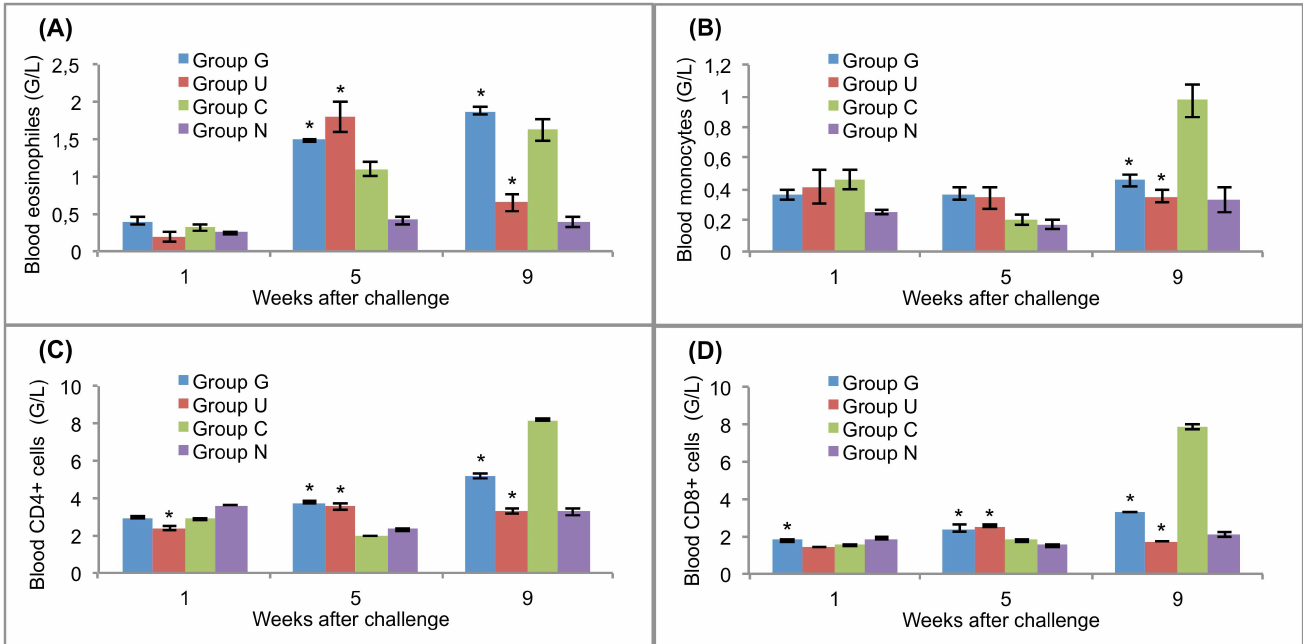
Fig 4. Leukocyte responses in the blood of vaccinatedand control rats to challenge infections. (A) eosinophils. (B) monocytes. (C) CD4+ T lymphocytes. (D) CD8+ T lymphocytes. Group G–Lyophilised lettuce expressingthe mature CPFhW enzyme flankedby Gly-rich linkers; Group U– Lyophilised lettuce expressingthe mature CPFhW protein fused with ubiquitin;Group C–Lyophilised control lettuce; Group N–None. At each timepoint, four rats from each group were euthanised and dissected. * Indicatessignificantly increasednumbers of cells ( p < 0.05). Error bars indicatestandard